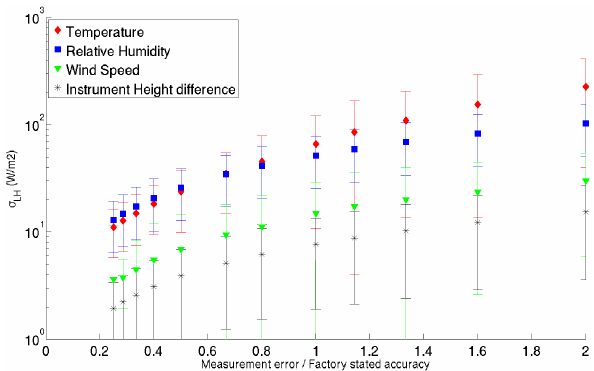
of blowing snow on flux estimation by the profile method.